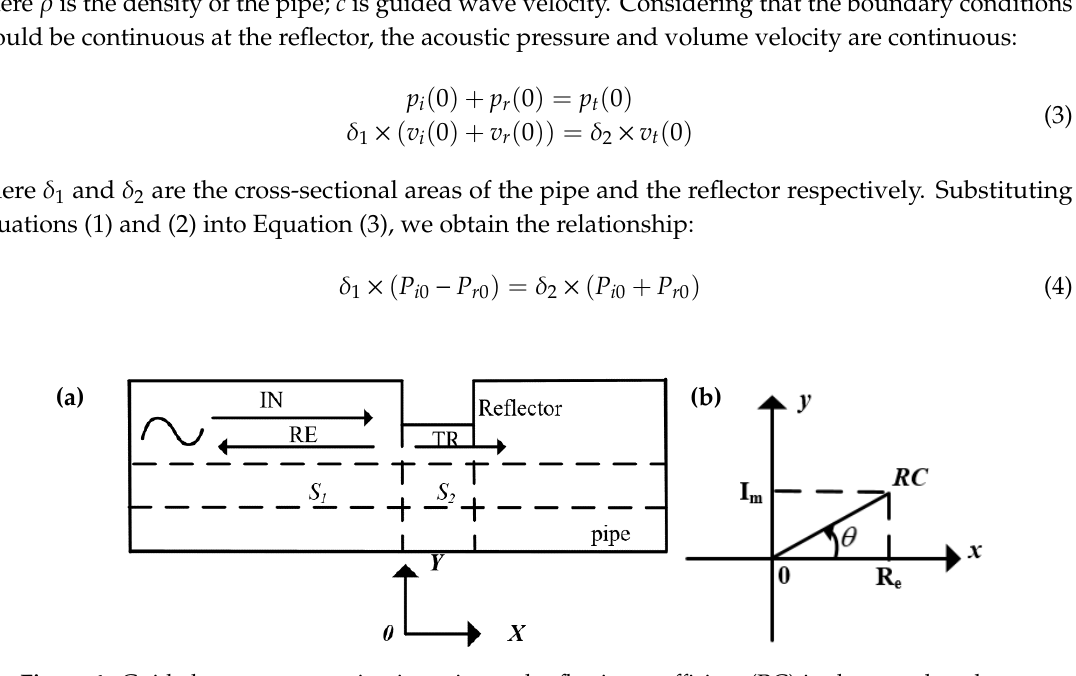
Figure 4. Guided wave propagation in a pipe and reflection coefficient (RC) in the complex plane: ( a ) guided wave propagation in a pipe with a reflector; ( b ) RC in the complex